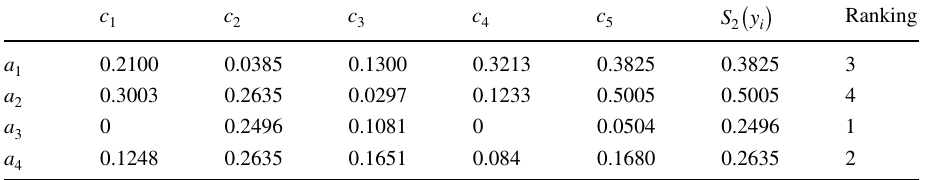
Table 11 Ranking by the PF-RP approach